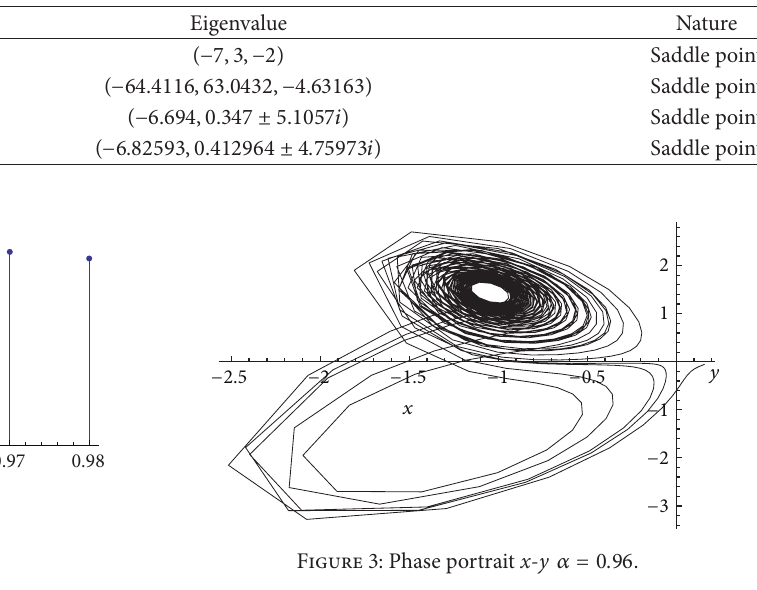
Figure 1: Lyapunov exponent.